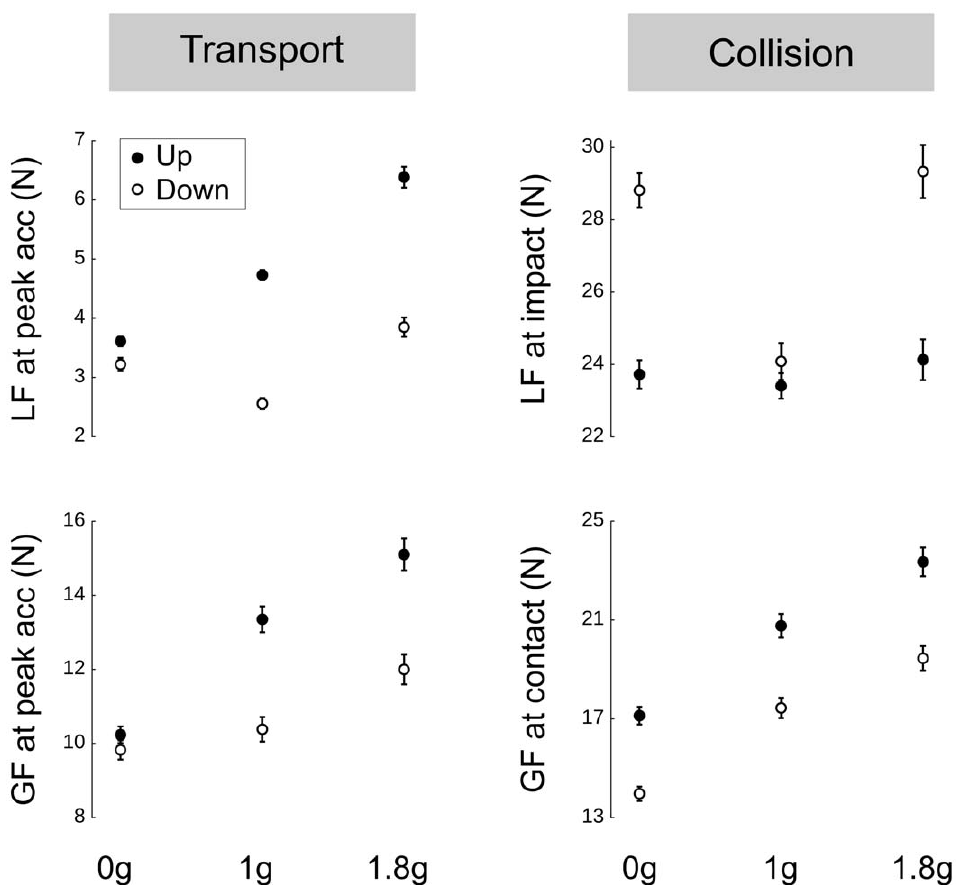
Figure 2. Grip force and load force in the transport and collision phases. Grip force and load force were coupled in the transport phase (left column) but not in the collision phase (right column). Forces are plotted in the two directions (up vs. down) and in three gravity phases (0 g, 1 g and 1.8 g). During transport, both load force and grip force are plotted at peak hand acceleration. At collision, load force is the magnitude of impact and grip force was recorded at contact (8 ms before peak load force), to avoid any artefact. Closed and open disks represent upward and downward movements respectively. Error bars represent between participants SE.